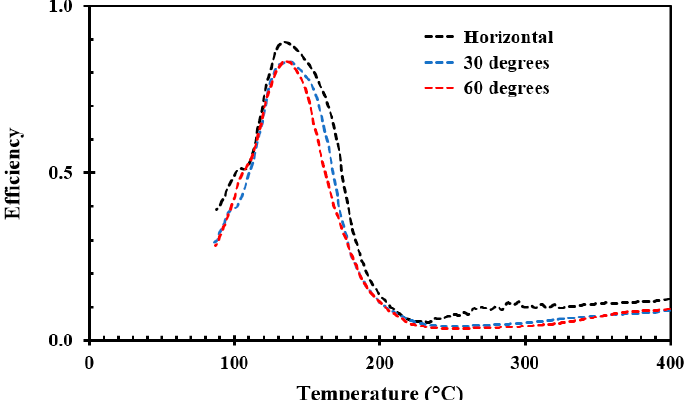
Figure 16. Cooling efficiency for 700 ppm acetone water solution for droplet diameter 2.5 mm, and various orientations at impingement height 25 cm (speed 2.2 m/s).